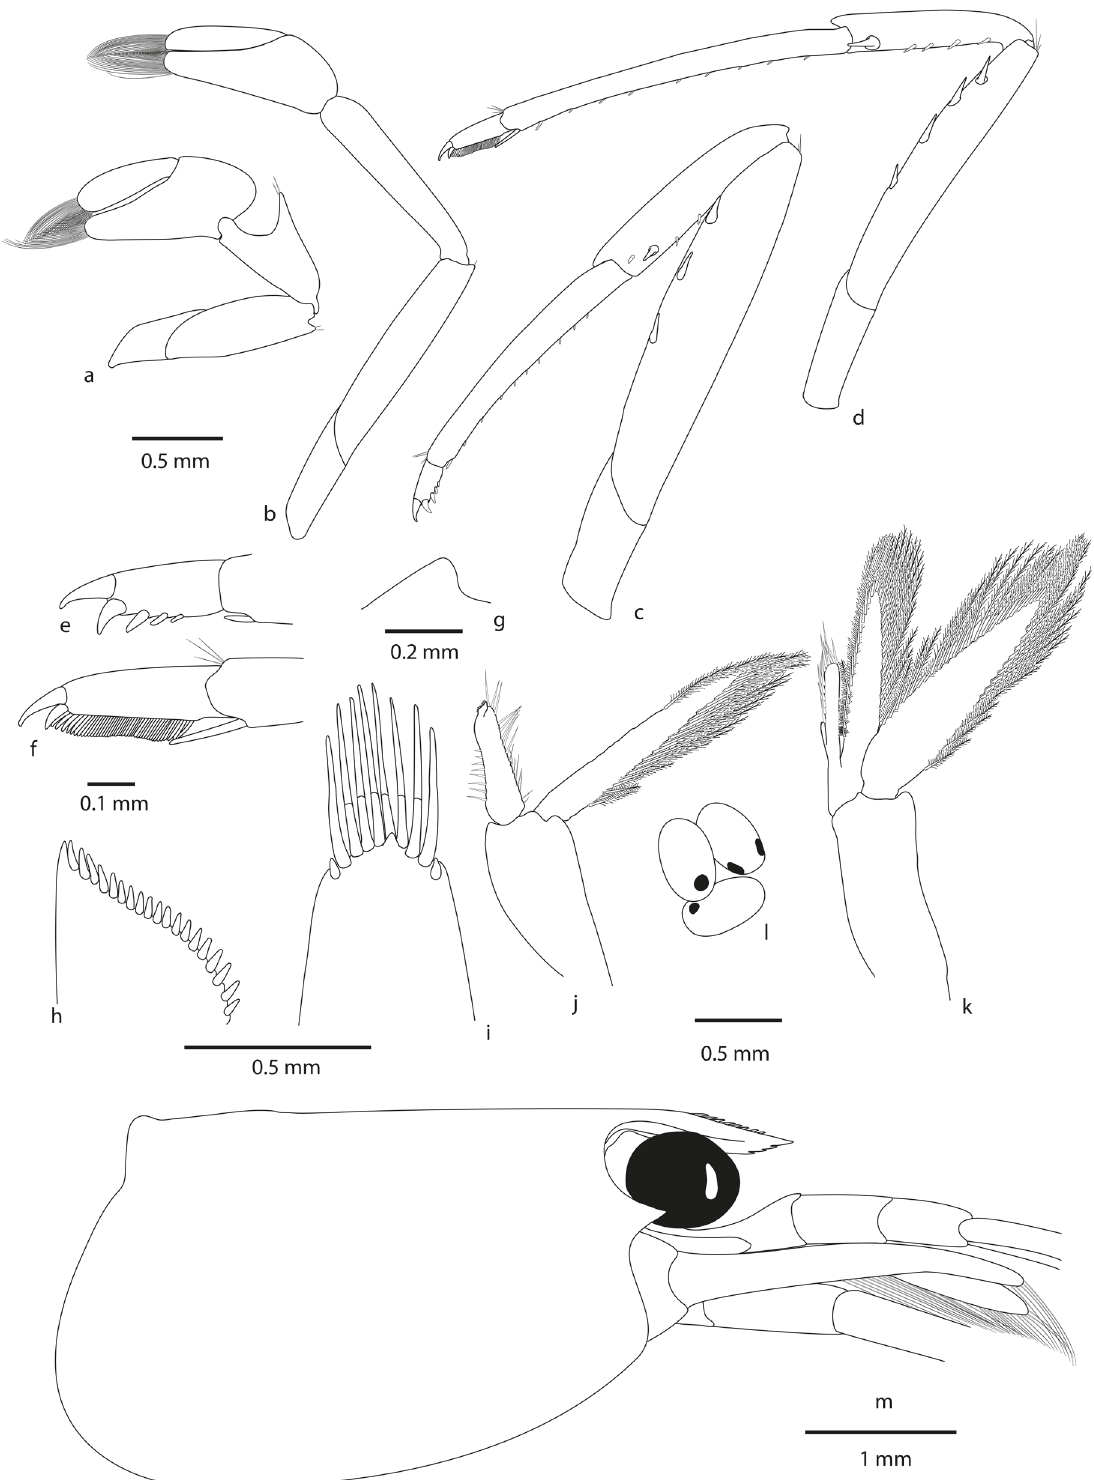
Fig. 17. Caridina maeana sp. nov. a . First pereiopod. b . Second pereiopod. c . Third pereiopod. d . Fifth pereiopod. e . Dactylus of third pereiopod. f . Dactylus of fifth pereiopod. g . Pre-anal carina. h . Uropodal diaeresis. i . Telson. j . First male pleopod. k . Second male pleopod. l . Eggs. m . Cephalothorax.